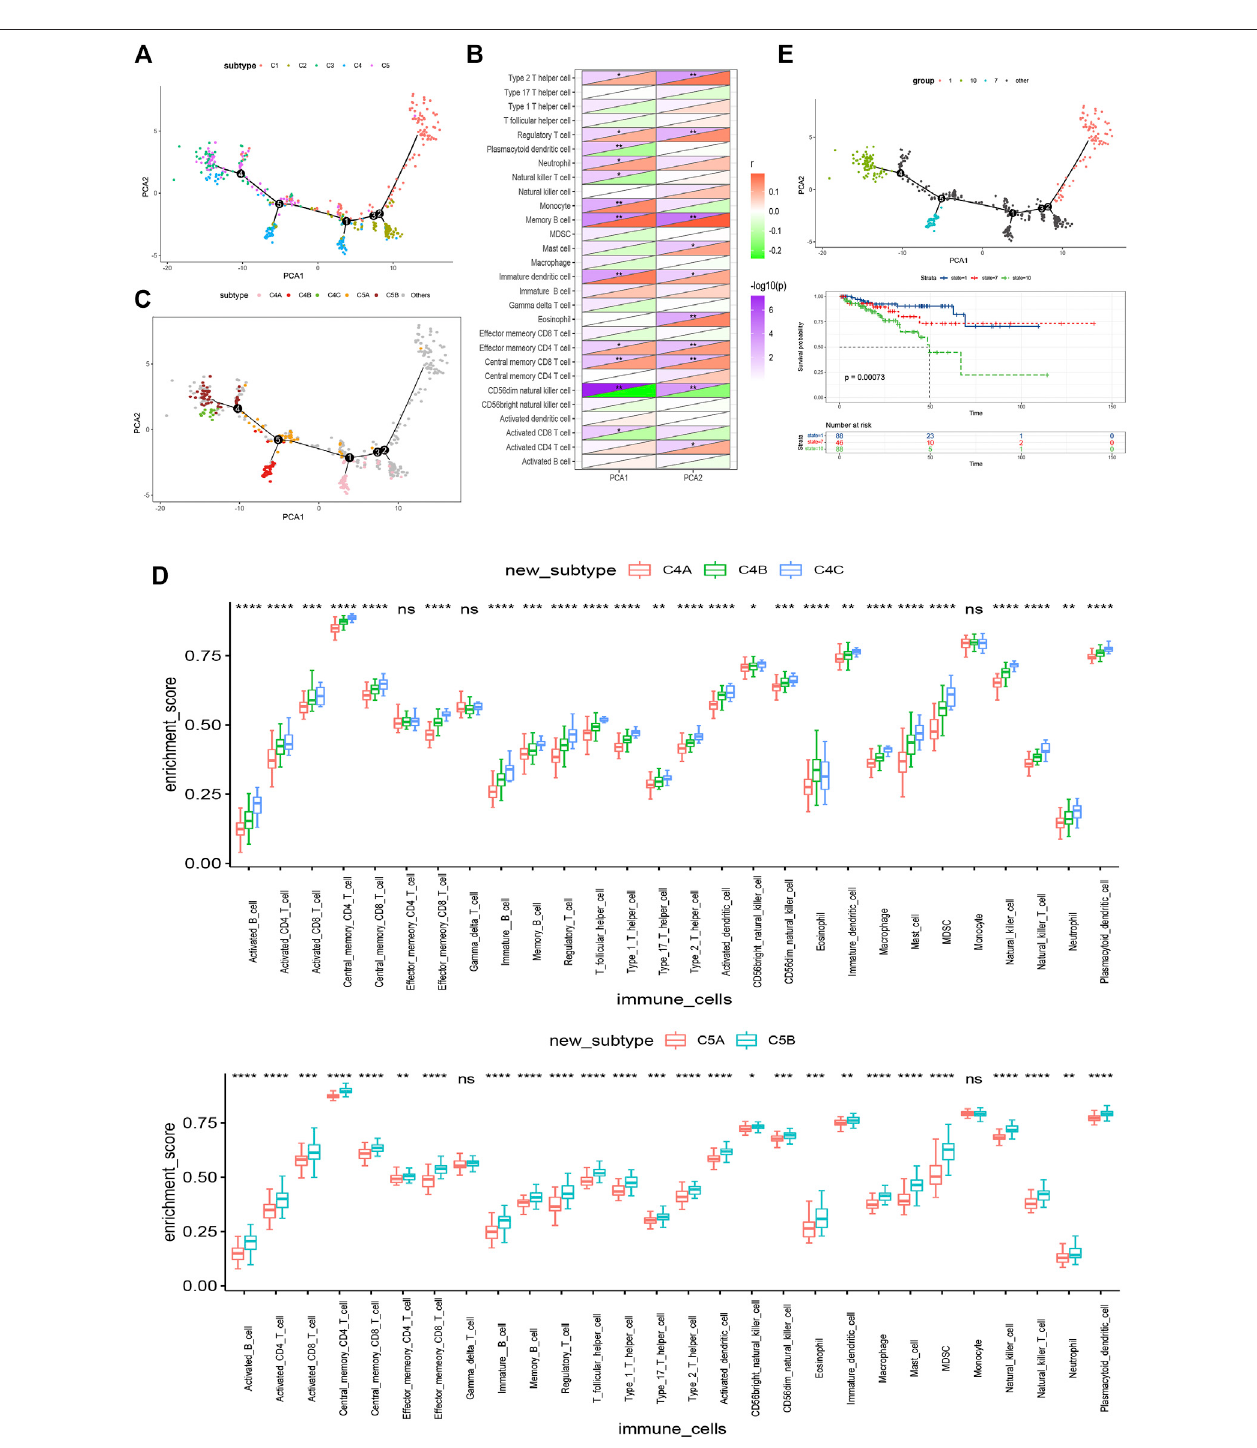
FIGURE 9 | Immune landscape of PRAD. (A) Immune landscape of PRAD. each point represents a patient and the immune subtypes are color-coded. The horizontalaxisrepresentsthe fi rstprincipalcomponentandtheverticalaxisrepresentsthesecondprincipalcomponent. (B) Heatmapoftwoprincipalcomponentswith 28immunecellsignatures. (C) ImmunelandscapeofthesubsetsofPRADimmunesubtypes. (D) Differentialenrichmentscoresof28immunecellsignaturesintheabove subsets. (E) Immune landscape of samples from three extreme locations and (F) their prognostic status.